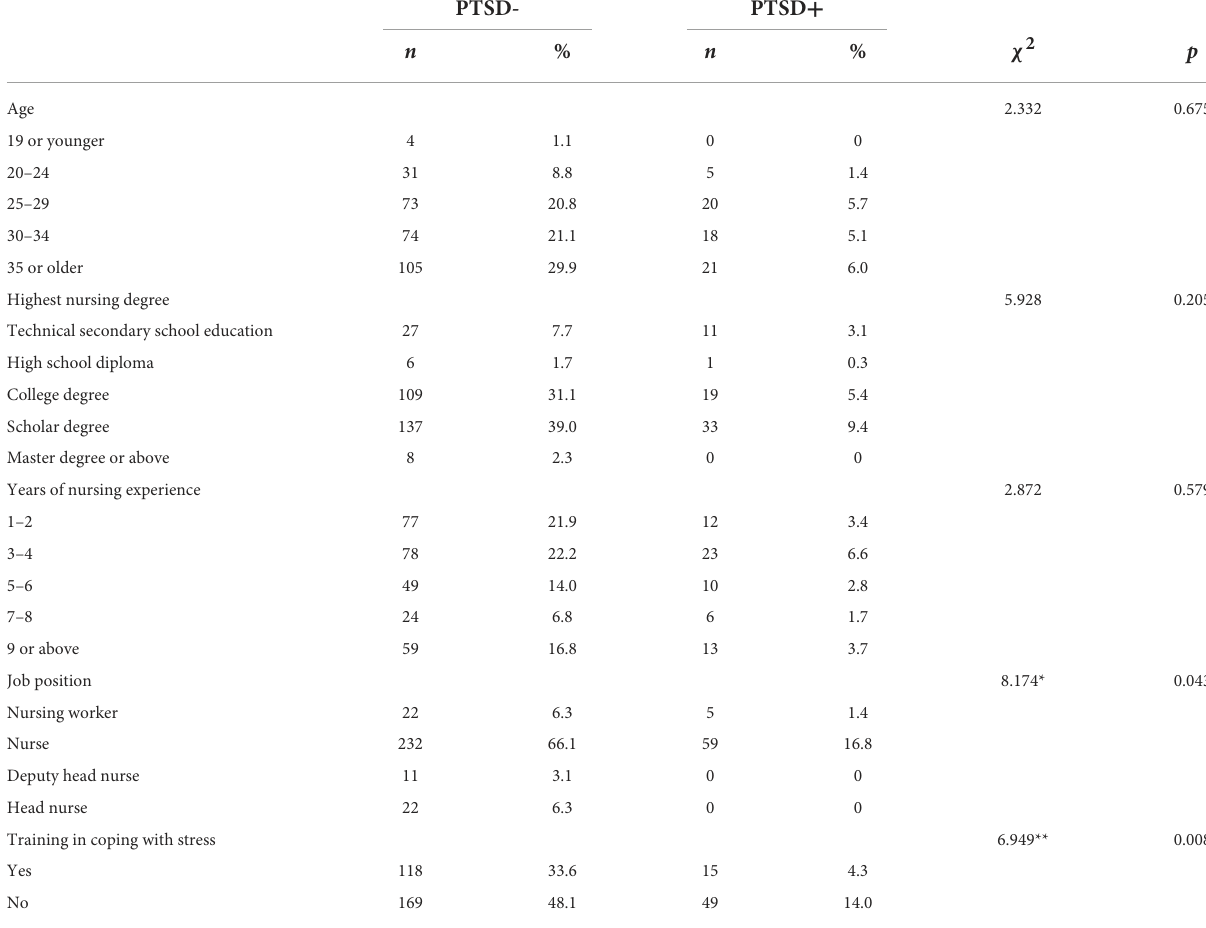
TABLE 1 Sociodemographic characteristics and PTSD symptoms among the overall sample. PTSD- PTSD